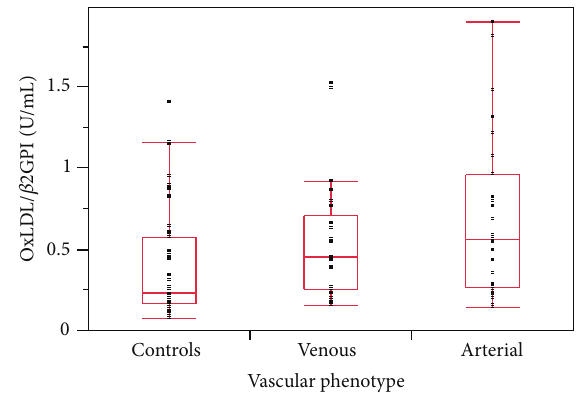
Figure 2: Distribution of serum levels of oxLDL/ 𝛽 2GPI complexes measured in 27 patients with arterial disease. Mean oxLDL/ 𝛽 2GPI levels of CarAD ( 0.85 ± 0.59 U/mL, 𝑃 = 0.013 ) and PAD ( 0.72 ± 0.54 U/mL, 𝑃 = 0.033 ) were significantly higher compared to healthy controls ( 0.38 ± 0.33 U/mL), while AAA ( 0.52 ± 0.38 U/mL, 𝑃 = 0.255 ) were not. The trend among the arterial disease groups was not statistically significant ( 𝑃 = 0.466 , Wilcoxon/Kruskal- Wallis Rank Sum test). Boxes represent 75/25 percentiles with the horizontal line the median for the group and whiskers the 90/10 percentile